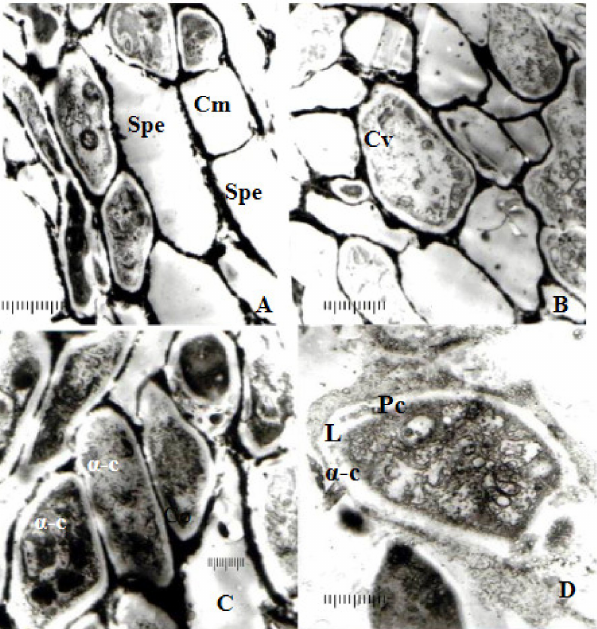
Figure 9. The ultrastructural organization of the pycnidia peridia—( A , B ) longitudinal sections: Cm—dead cells; Spe—intercellular spaces, (bar = 10 µ m); Cv—living cells; (bar = 10 µ m); ( C , D ) — Cross-sections and longitudinal sections through α -conidia in different ontogenetic stages: α -c-young α -conidia, Pc—cellular wall, L—lipids, Co—enteroblastic conidiogenesis; (bar = 1 µ